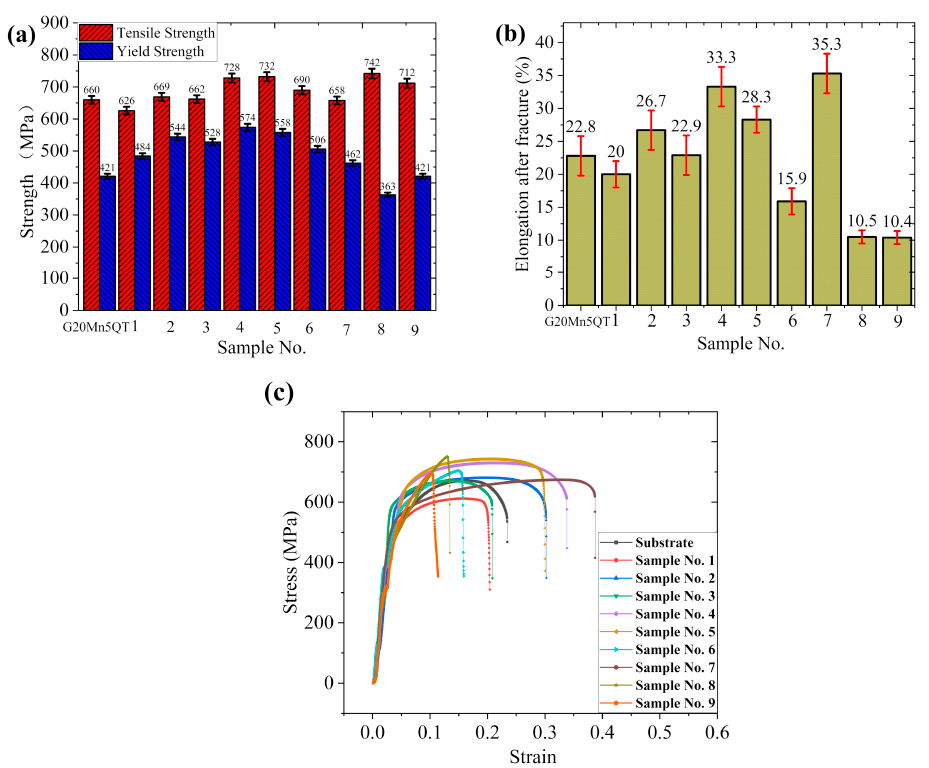
Figure 9. Tensile test results: ( a ) tensile properties; ( b ) elongation after fracture; ( c ) stress-strain curve.